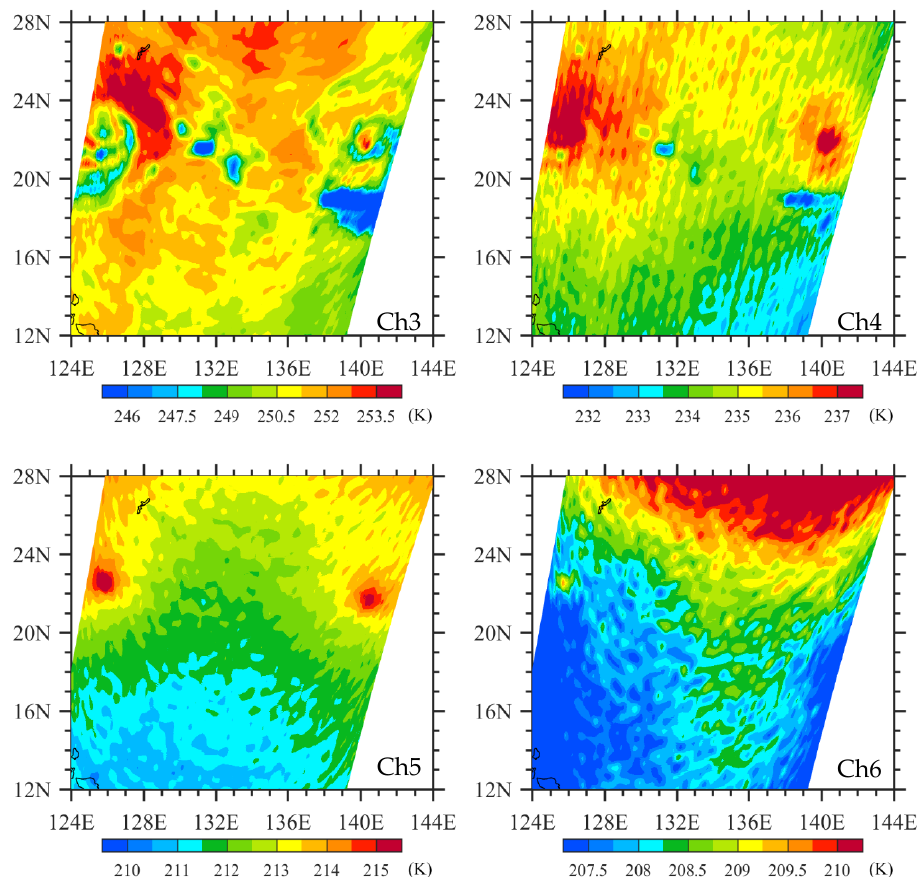
Figure 5. Same as Figure 4 except for having removed the along-track high-frequency noise (greater than 0.07 s − 1 ) by the Fast Fourier Transform (FFT) method.